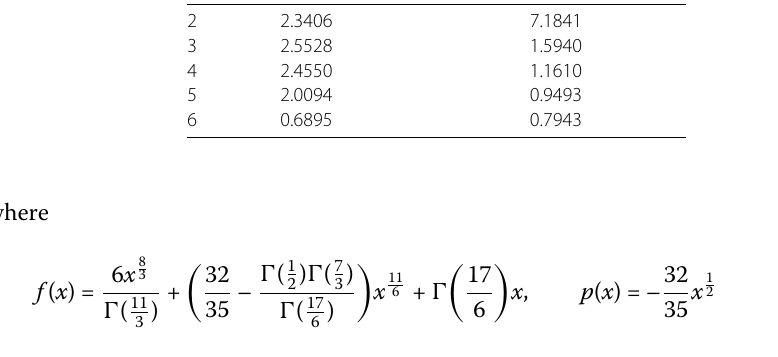
m Convergence Example 2 for α = 2/3 Example 3 for α =